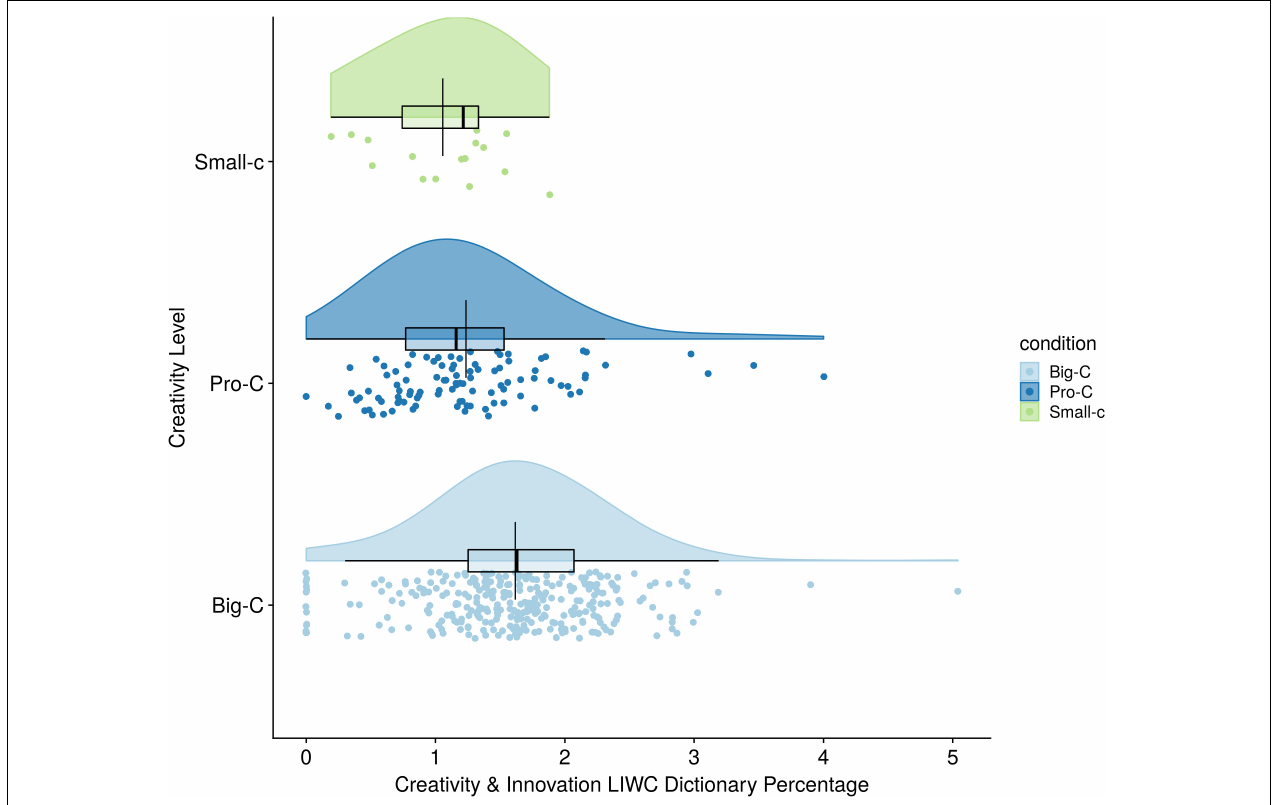
FIGURE 1 | Creativity level differences on creativity and innovation LIWC dictionary frequency